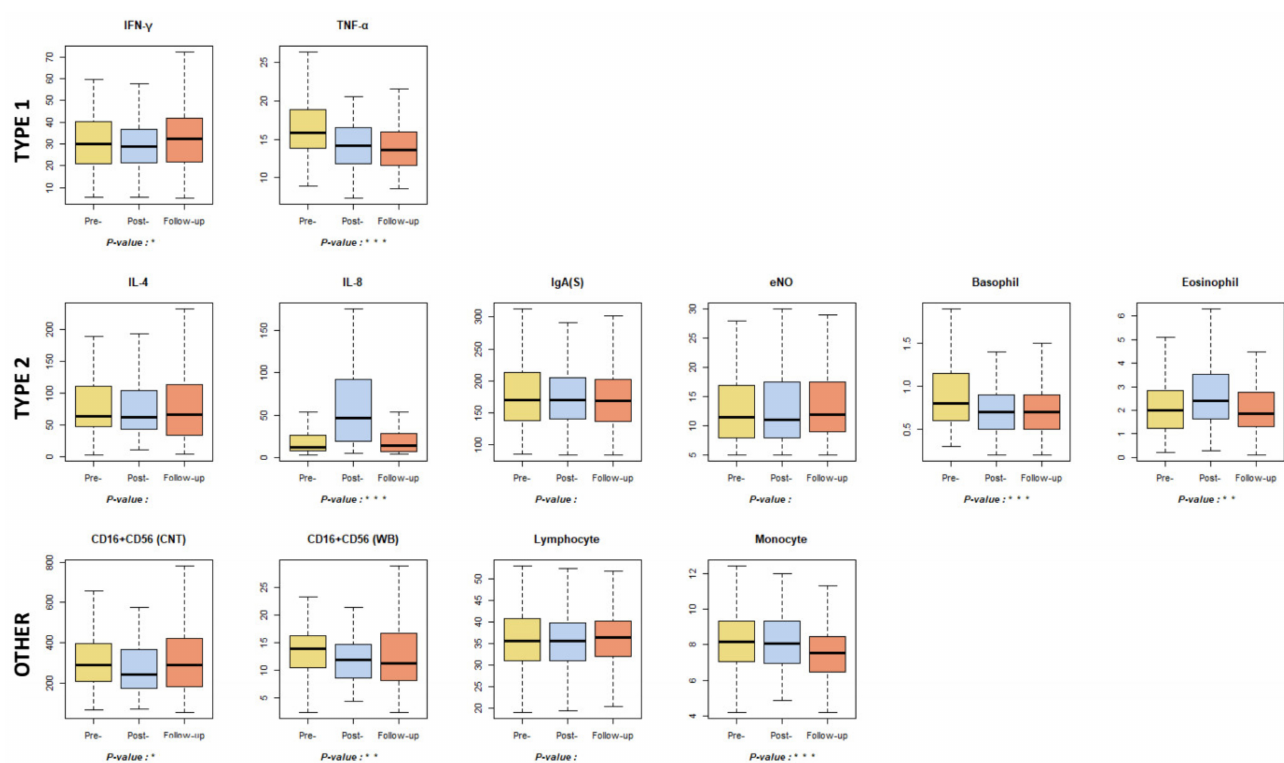
Figure 6. Results of immune function and inflammation-related indicators. * p < 0.05, ** p < 0.01, *** p < 0.001. Pre-: daily health conditions two weeks prior to the forest healing program; Post-: health conditions immediately after the forest healing program; Follow-up: daily health conditions one, two, and four weeks after the forest healing program; IFN: interferon; TNF: tumor necrosis factor; IL: interleukin; IgA: Immunoglobulin A; eNO: exhaled nitric oxide; CD: cluster of differentiation molecule.